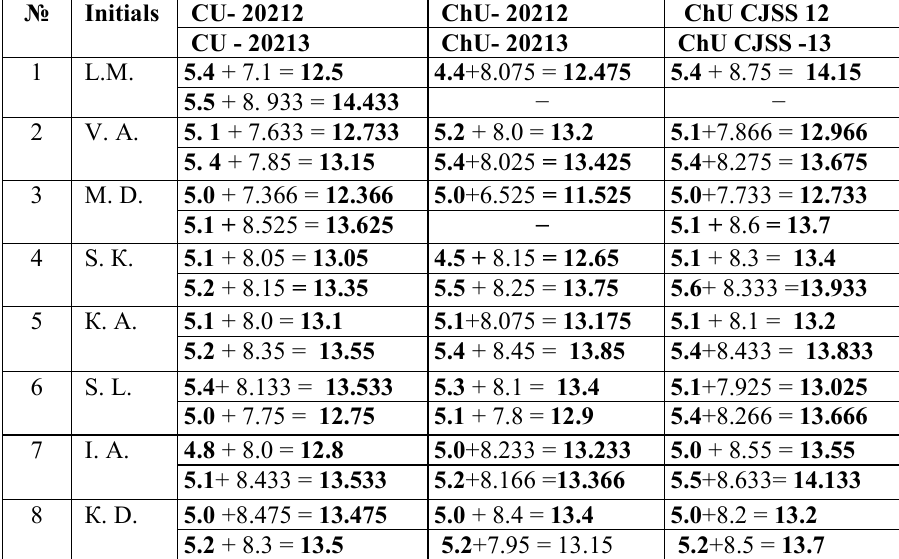
Results of competitions of Ukrainian sport gymnastic combined team (women), n=8